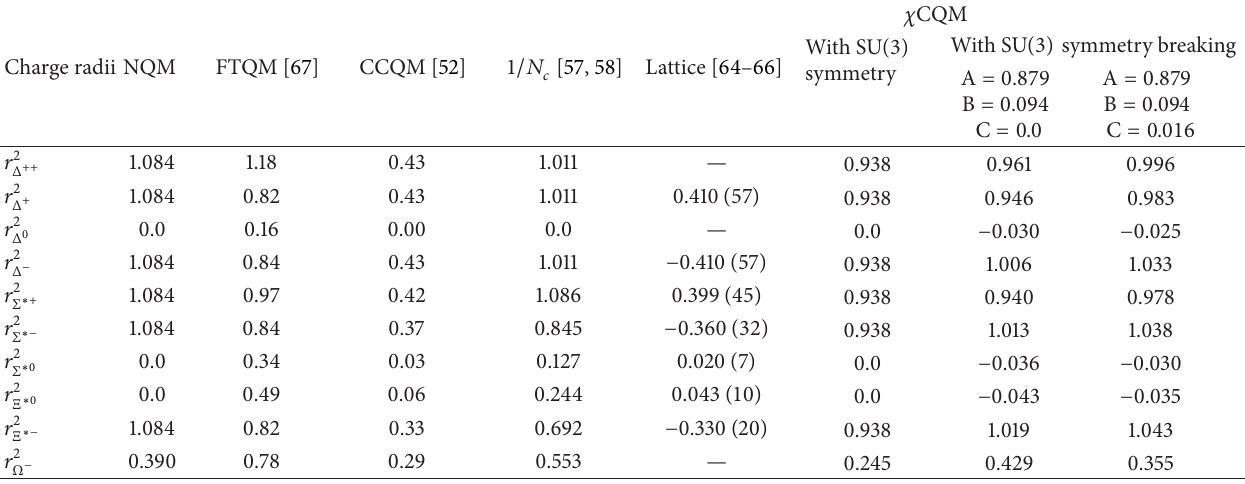
Table 6: Charge radii of decuplet baryons calculated in 𝜒 CQM in comparison with other phenomenological models (in units of fm 2 ).